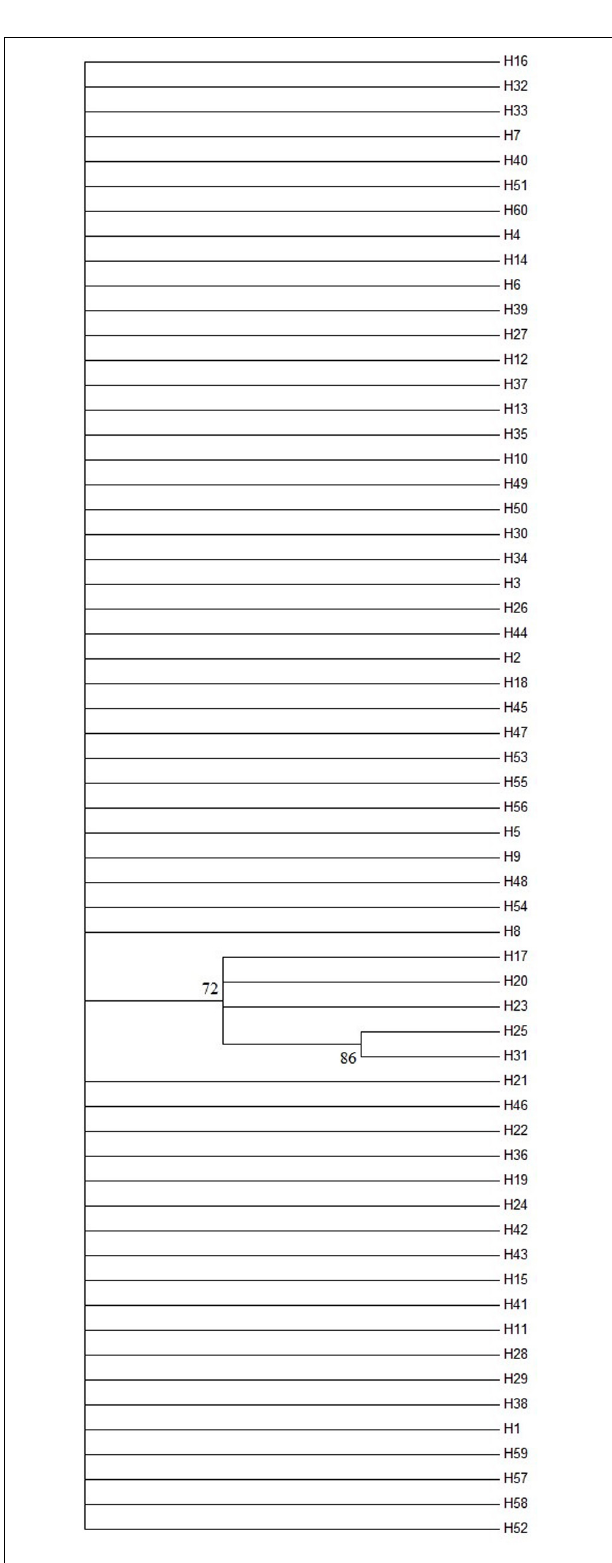
FIGURE 2 | Neighbor-joining phylogenetic tree of Konosirus punctatus developed using COI data. The detailed haplotype representation is similar as shown in Figure 4 . Branch support values (higher than 70%) in